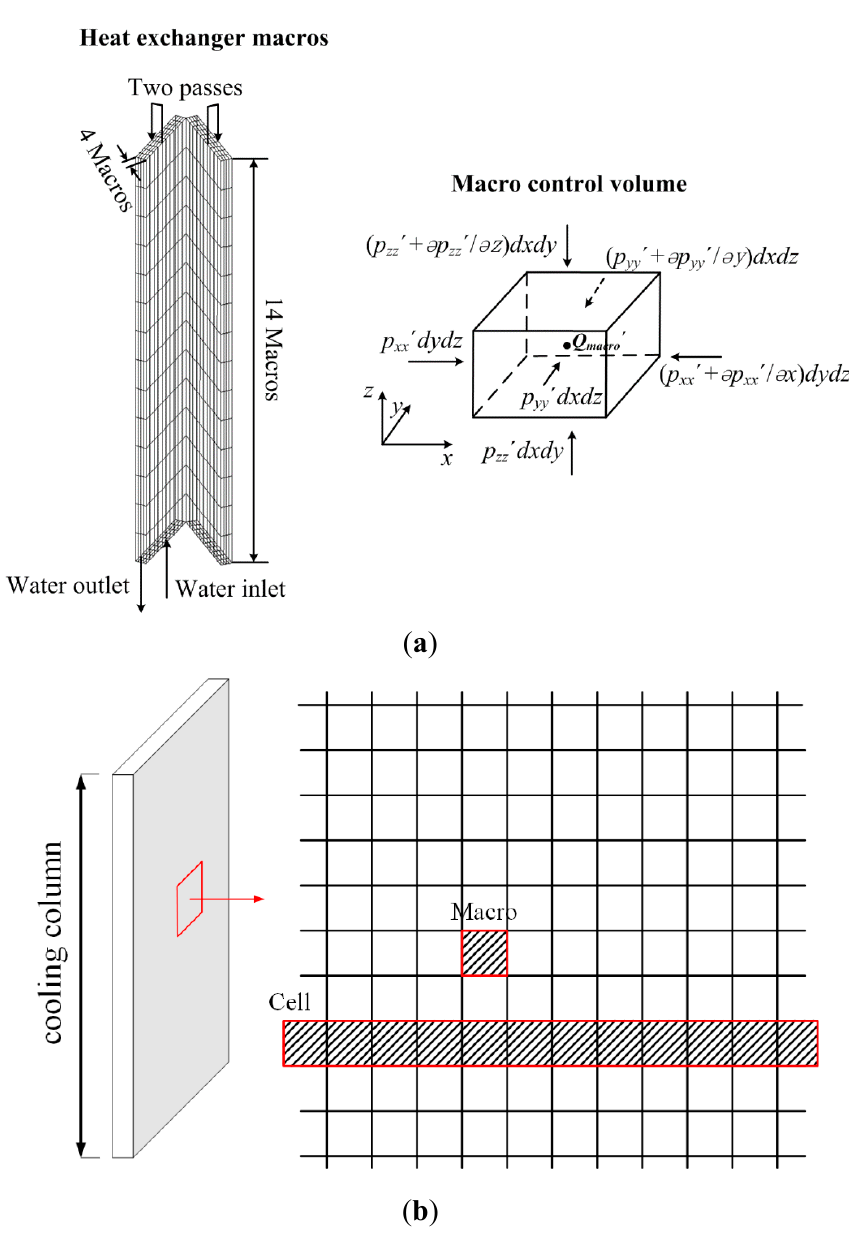
Figure 3. Schematic of control volume unit of heat exchanger. ( a ) Macro and cell control volume, ( b ) detailed micro and cell unit.